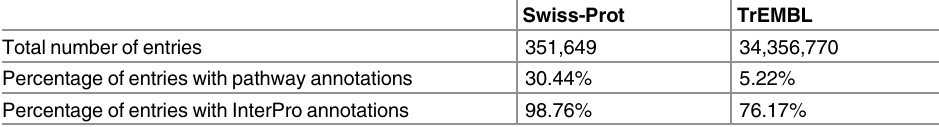
Table 1. Current status in UniProtKB for prokaryotes.